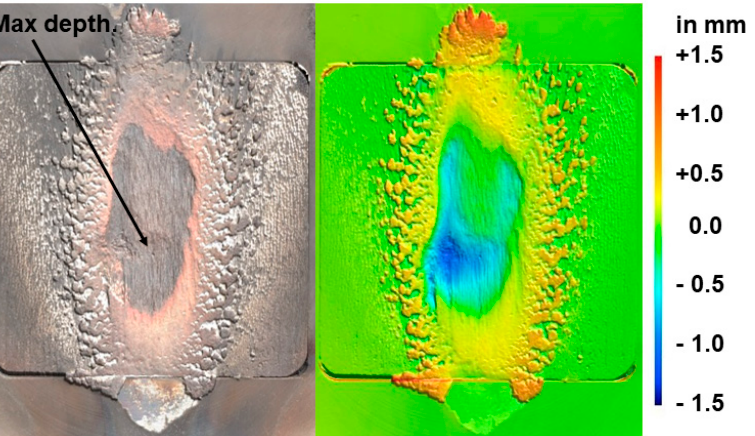
Figure 6. Surface of a sample after VMK testing using the 8% Al propellant; ( left ) optical view, ( right ) colour-coded contour map of the same image.